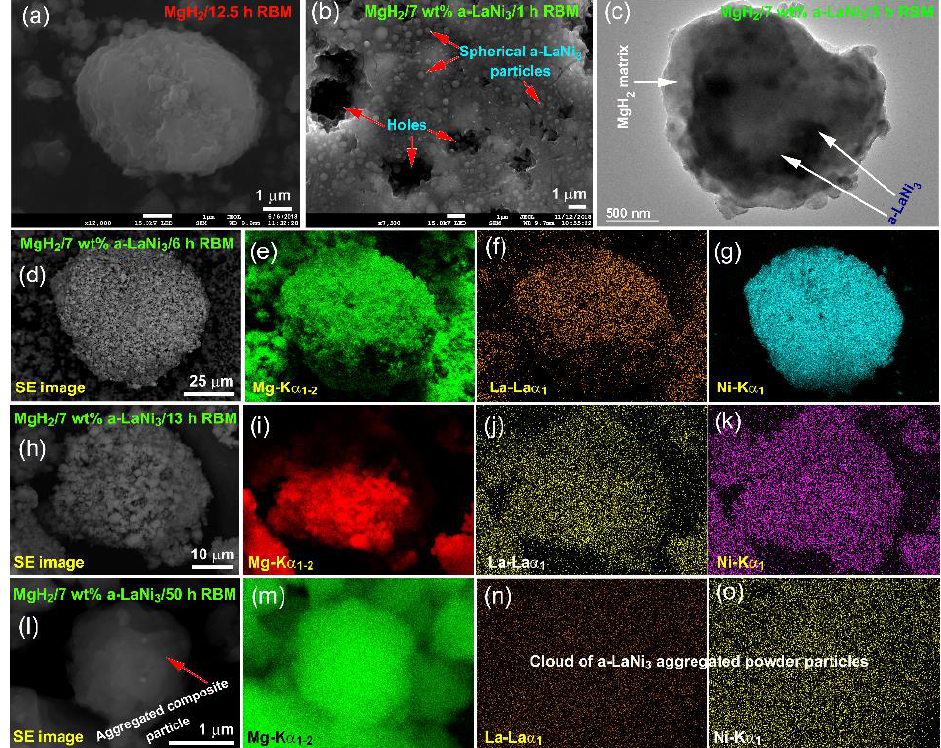
Figure 6. FE-SEM micrographs of ( a ) MgH 2 powders obtained after 12.5 of RBM, and ( b ) MgH 2 powders doped with a-LaNi 3 powders and ball milled for 1 h. The STEM image of MgH 2 /7 wt% a-LaNi 3 composite powders obtained after 3 h of milling is displayed in ( c ). Scanning electron (SE) images of the composite powders obtained after 6 h, 13 h and 50 h are presented in ( d ), ( h ) and ( l ), respectively, where the corresponding EDS elemental mapping of Mg are shown in ( e ), ( i ), ( m ). The EDS elemental mapping images displayed in ( f ), ( j ) and ( n ) are corresponding to elemental La, however, those images presented in ( g ), ( k ) and ( o ) are related to elemental Ni.